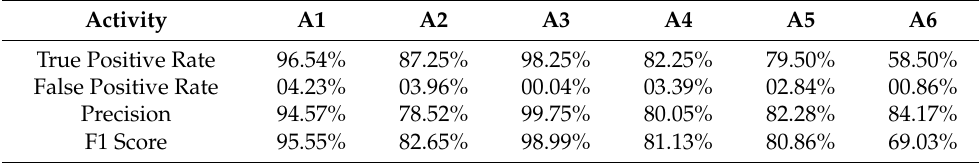
Table 11. The results of our proposed approach obtained for the third evaluation